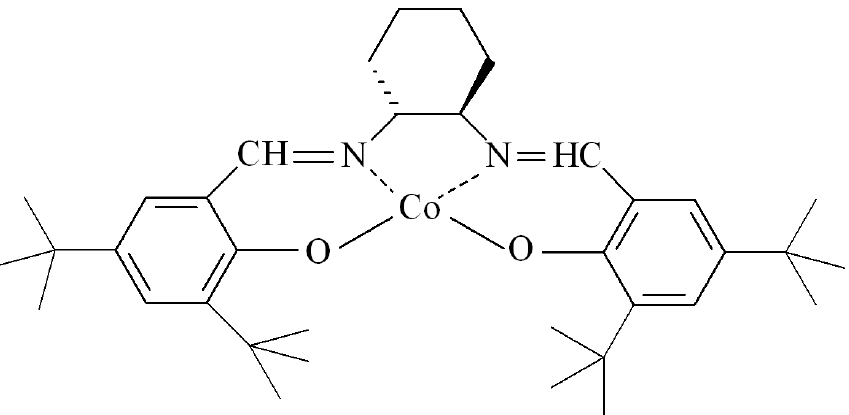
Scheme 1 The structure of the ( R, R )-(-)- N, N (cid:48) -bis(3,5-di- tert -butylsalicylidene)-1,2- cyclohexanediaminocobalt(II) complex ( I